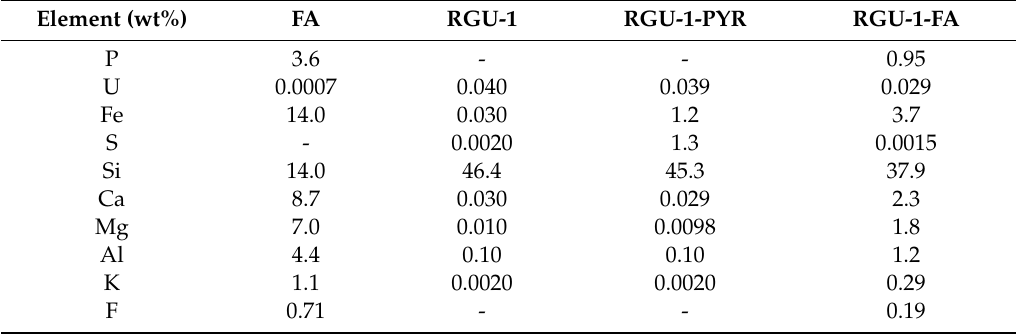
Table 1. Used samples and content of their main elements (wt%). FA: fluorapatite ore, RGU-1: reference uranium ore, RGU-1-PYR: mixed pyrite and reference uranium ore, RGU-1-FA: mixed fluorapatite and reference uranium